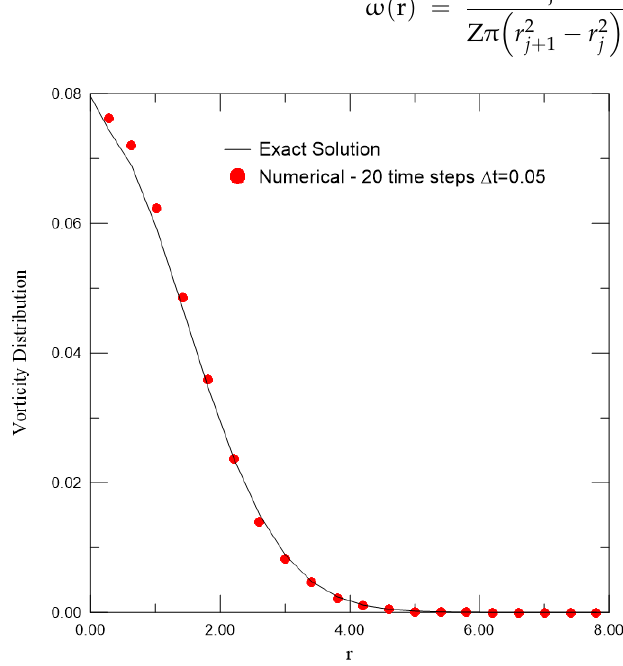
Figure 5. Prediction of the vorticity radial diffusion of a vortical structure by the random walk method ( v = 1.0 and Re = 1.0).